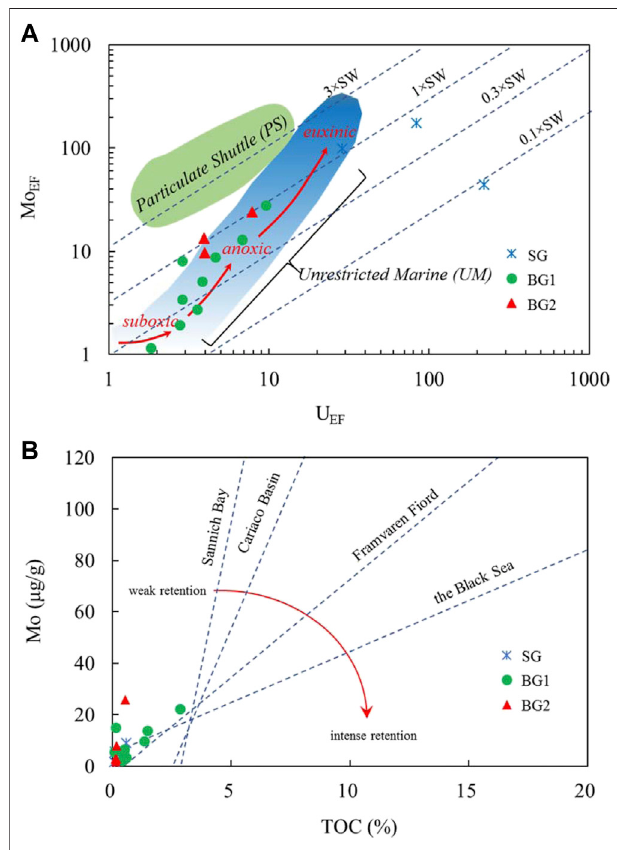
FIGURE 5 | (A) U – EF vs. Mo – EF for samples of the Lower Cambrian paleoenvironment.SamplesaretakenfromtheYuertusiformationoftheYutixi outcrop[modi fi edfromAlgeoandTribovillard(2009)]. (B) Totalorganiccarbon contents vs. Mo concentration ([TOC] vs. [Mo]) diagrams drawn for the Yuertusi formation studied in this paper. Such diagrams are designed to assess the paleodegree of water mass restriction in oxygen-limited marine basins (Algeo and Lyons, 2006; Algeo et al., 2007). The solid lines represent four present-day basins characterized by some restriction of the water mass circulation.TherestrictionseverityincreasesfromtheSannichbaytotheBlack Sea (see explanations in Algeo and Lyons (2006) and Algeo et al. (2007)).